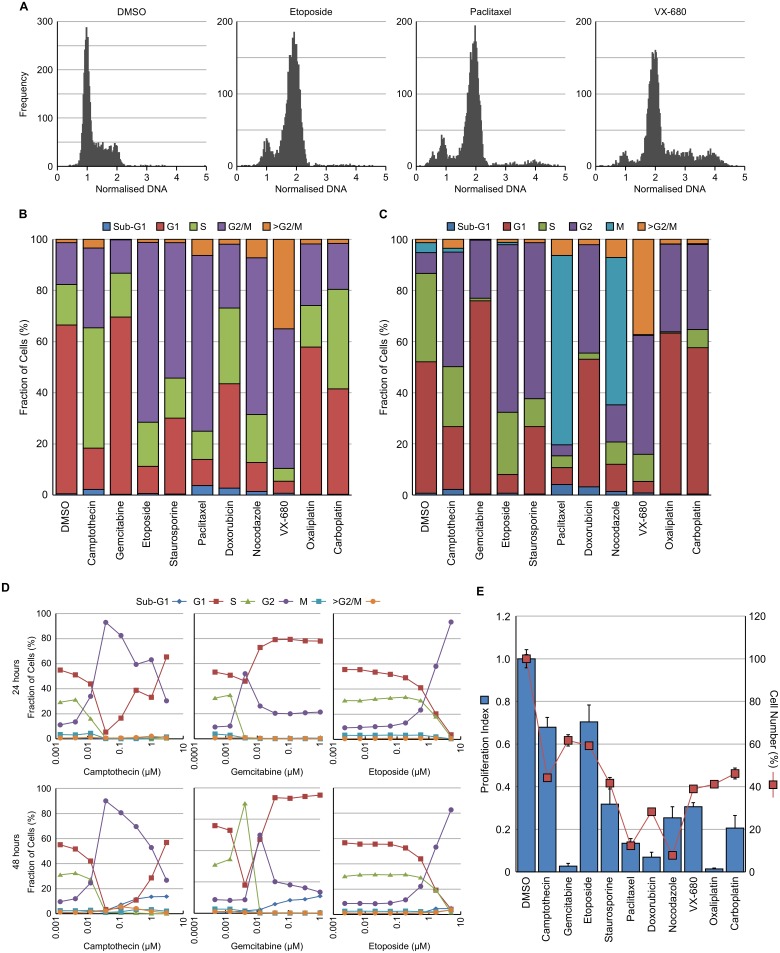
Validation of image analysis protocol.HT29 cells were treated with the indicated compound for 24 hour and then fixed and stained with Hoechst 33342, EdU and pHH3 (S10). (A) Example histograms following treatment with DMSO, etoposide, paclitaxel or VX680. Cell cycle distribution was determined using either DNA histogram analysis (B) or multiparametric analysis (C). (D) Time course and dose response of cell cycle changes determined using the multiparametric method for cells treated with camptothecin, gemcitabine or etoposide. (E) Proliferation index (EdU positive cells treated / EdU positive cells control) and cell number were determined from the images. Values are the average of 6 technical replicates.